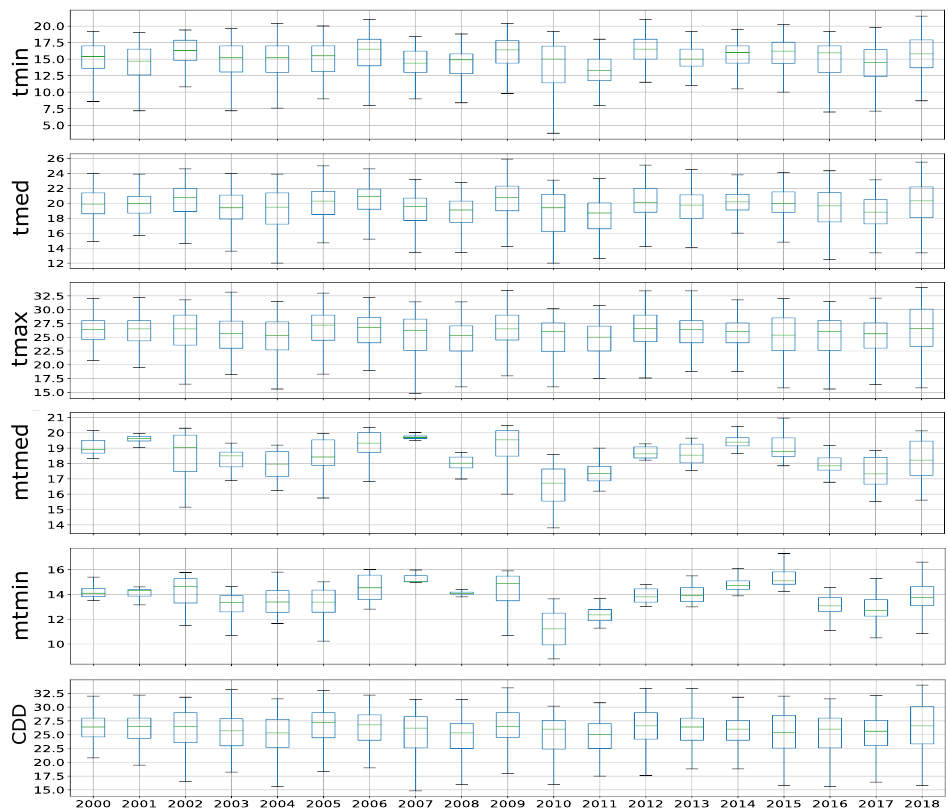
Figure 5. DS1 input variables